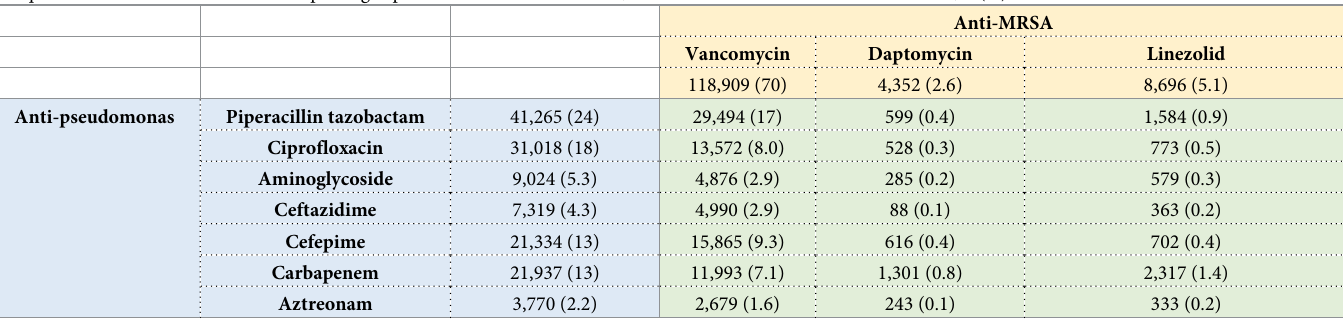
Table 3. Frequency of observations and risk of new or worsening AKI within 7 days associated with exposure to various anti-pseudomonas, anti-MRSA or their combination (multivariate). Frequencies of 24-hour observations reporting exposure to anti-Pseudomonas, anti-MRSA or both for the entire cohort, n (%)